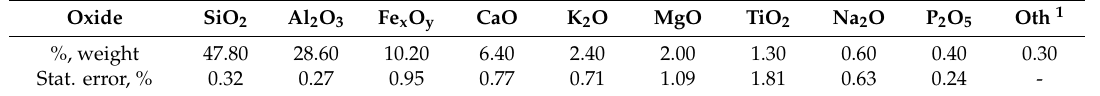
Table 1. Indigenous fly ash oxide chemical composition.